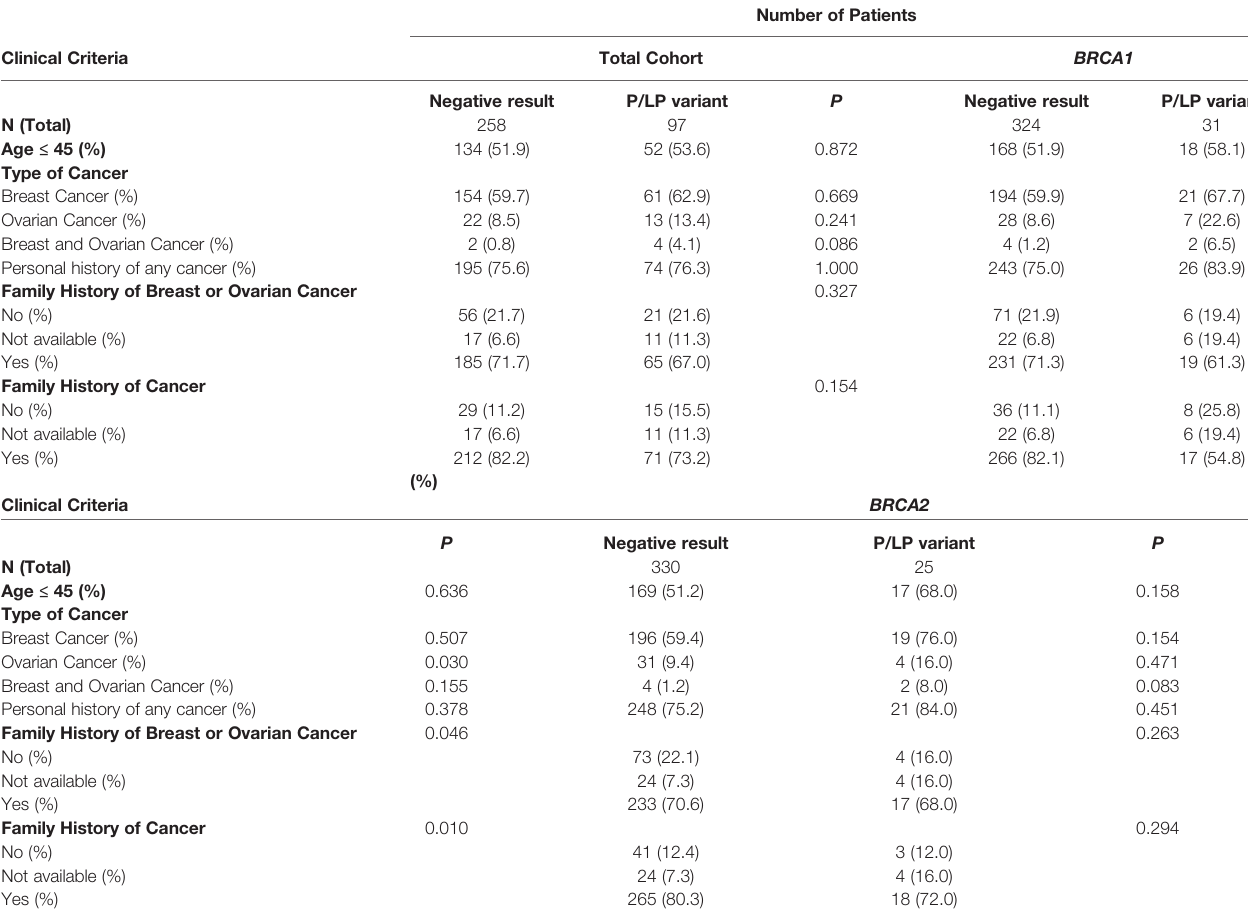
Number of Patients